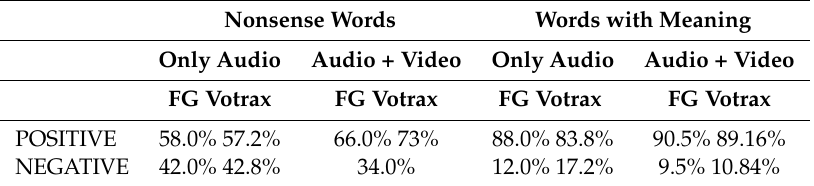
Table 3. Comprehension results: nonsense words vs. words with meaning.